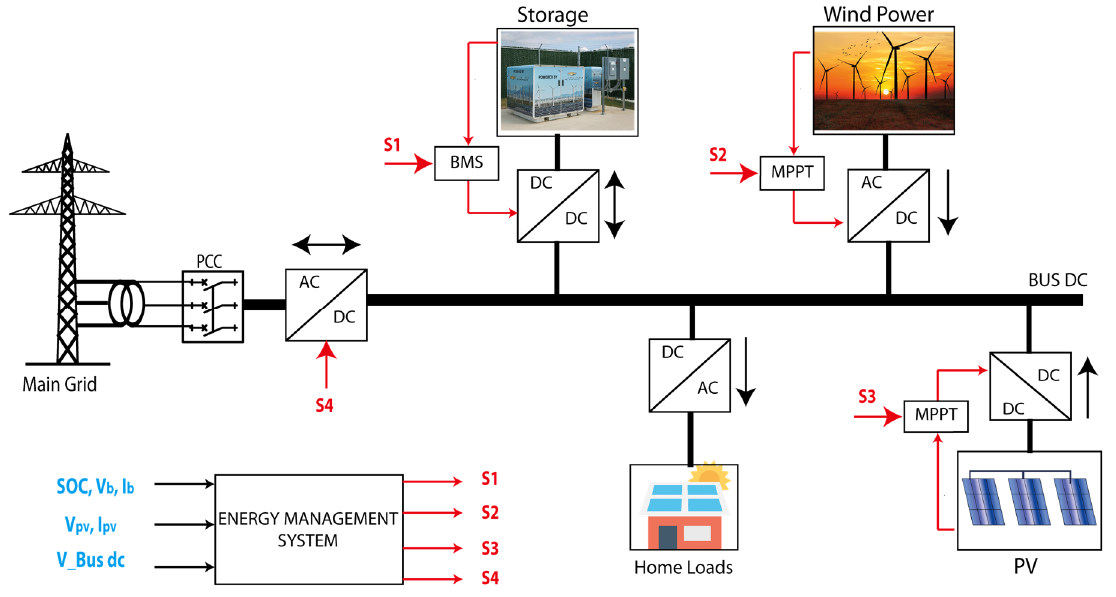
Figure 8. The proposed energy management system.